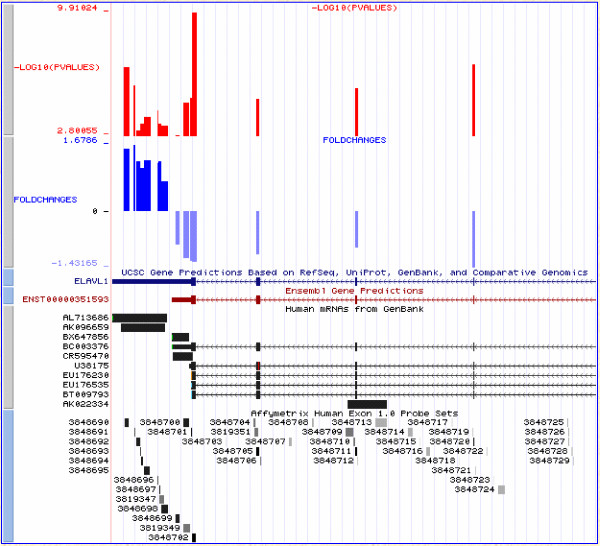
Visualization of expression patterns of ELAVL1 gene. The top two custom tracks display the Exon Array information from Figure 4: statistical significance and fold change. Note that the two probeset "blocks" correspond to the two isoforms of the gene. The long 3'UTR isoform is predominantly expressed in the brain, whereas the short isoform is more abundant in the reference tissues.